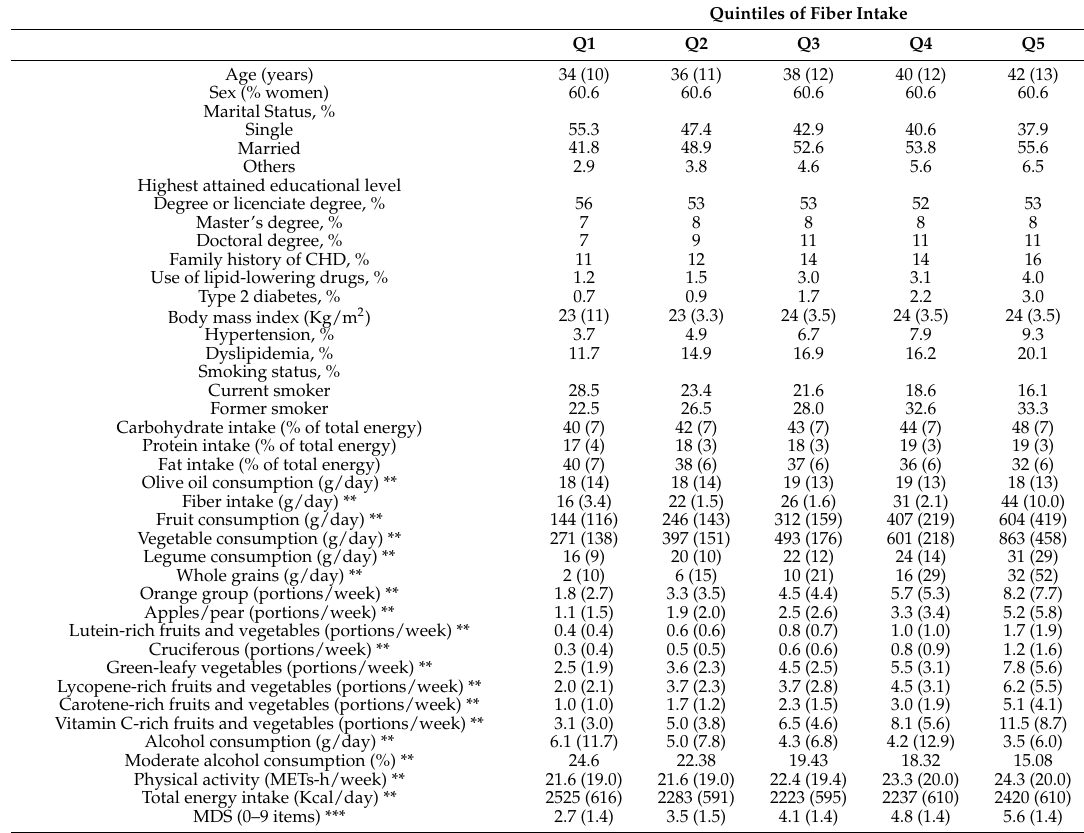
Table 2. Baseline characteristics * of the study participants according to baseline quintiles of fiber intake, SUN (Seguimiento Universidad de Navarra, Follow-up) Project 1999–2013.